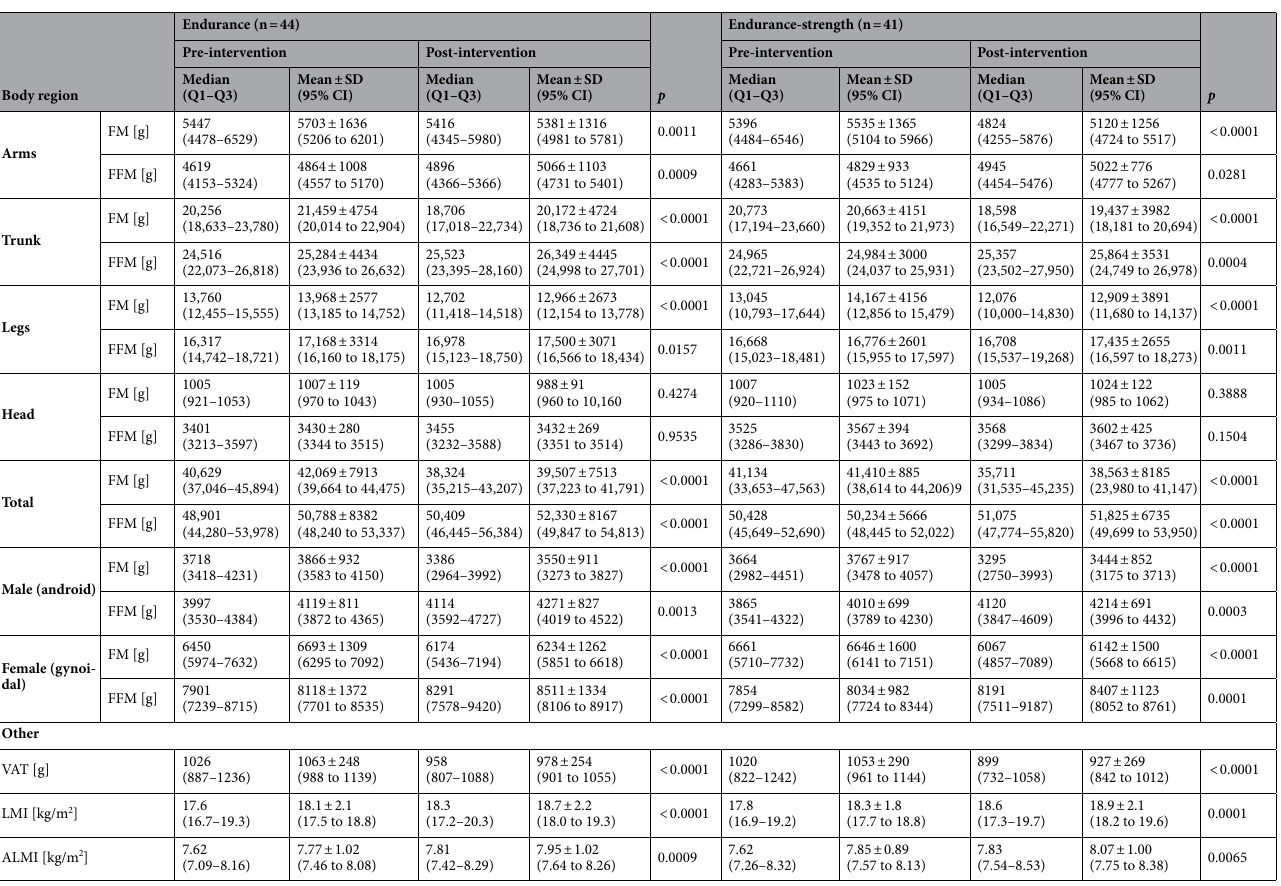
Table 3. Effects of endurance and endurance-strength training on body composition. ALMI appendicular lean mass index, FFM free fat mass, FM fat mass, LMI lean mass index, VAT visceral adipose